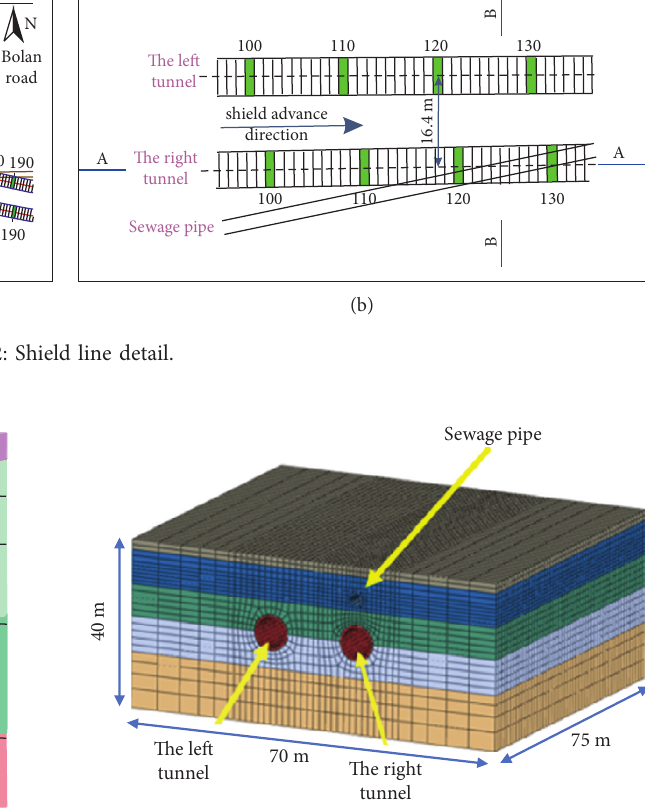
Figure 5: Dimensions and meshing of the